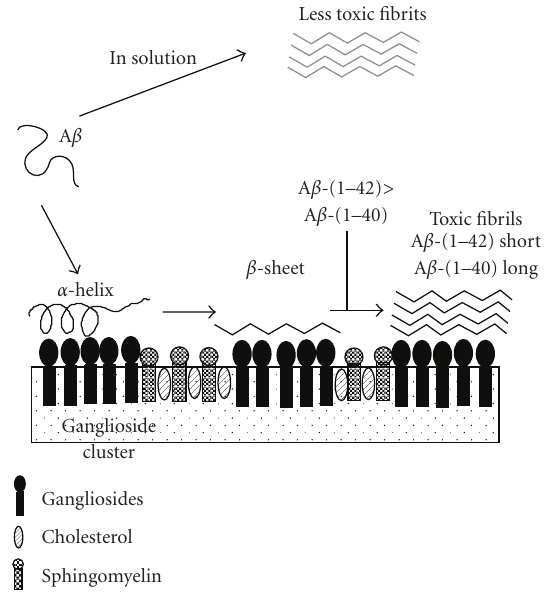
Figure 5: A model for the formation of toxic amyloid fibrils by amyloid β -protein on ganglioside clusters. A β is essentially soluble, and takes an unordered structure in solution. Once ganglioside clusters are generated, A β binds to the clusters, forming an α - helix-rich structure at lower protein-to-ganglioside ratios whereas the protein changes its conformation to a β -sheet at higher ratios. The β -sheet form facilitates the fibrillization of A β , leading to cytotoxicity. The amyloidogenic activity of A β -(1–42) is more than 10-fold that of A β -(1–40). Amyloid fibrils formed in solution are much less